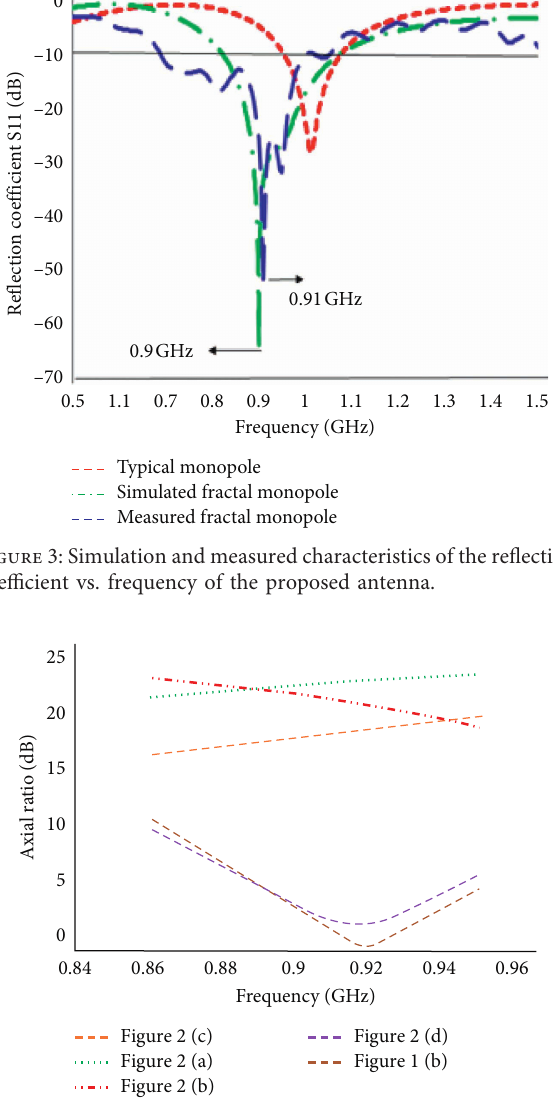
Figure 4: Simulated result: AR setup along the direction of the main lobe.